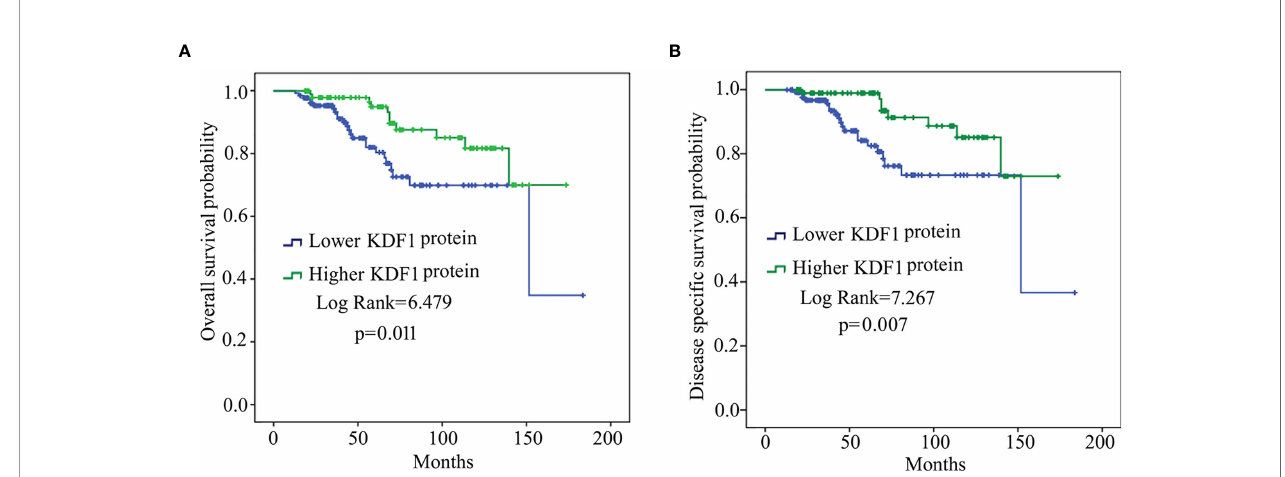
FIGURE 3 | Results of survival analysis of patients with clear cell renal cell carcinoma (ccRCC) based on KDF1 protein level in the tumor tissue. A total of 241 ccRCC patients were included. The patients were divided into lower KDF1 protein subgroup (with immunostaining score for KDF1 in the tumor tissue being 0 or 1, n=136) and higher KDF1 protein subgroup (with immunostaining score for KDF1 in the tumor tissue being 2 or 3, n=105) according to the level of KDF1 protein in the tumor tissue of the patients. The overall survival (A) and disease-speci fi c survival (B) were compared between the two subgroups by using Kaplan-Meier